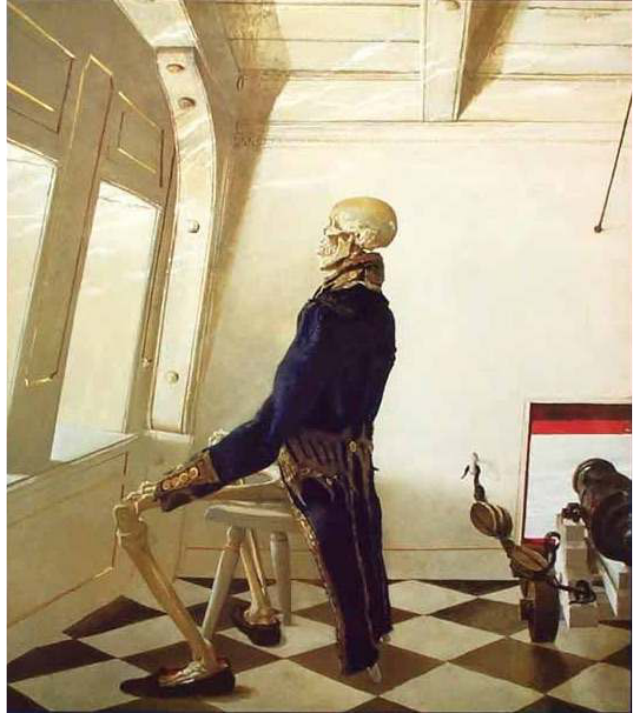
Figure 18. Andrew Wyeth, Dr. Syn . Tempera on panel